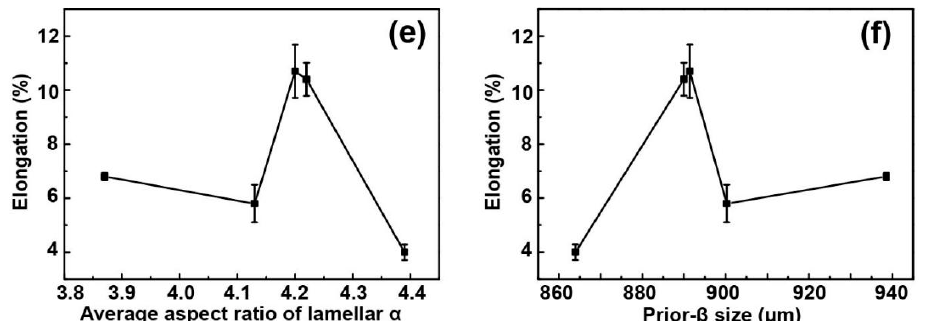
Figure 15. Variations in elongation and microstructural features. ( a ) Average length, ( b ) average width, and ( c ) volume fraction of lamellar α ; ( d ) average width of retained β ; ( e ) average aspect ratio of lamellar α ; and ( f ) prior- β size. Metals 2020 , 10 , 854 of lamellar α ; and ( f ) prior- β size.